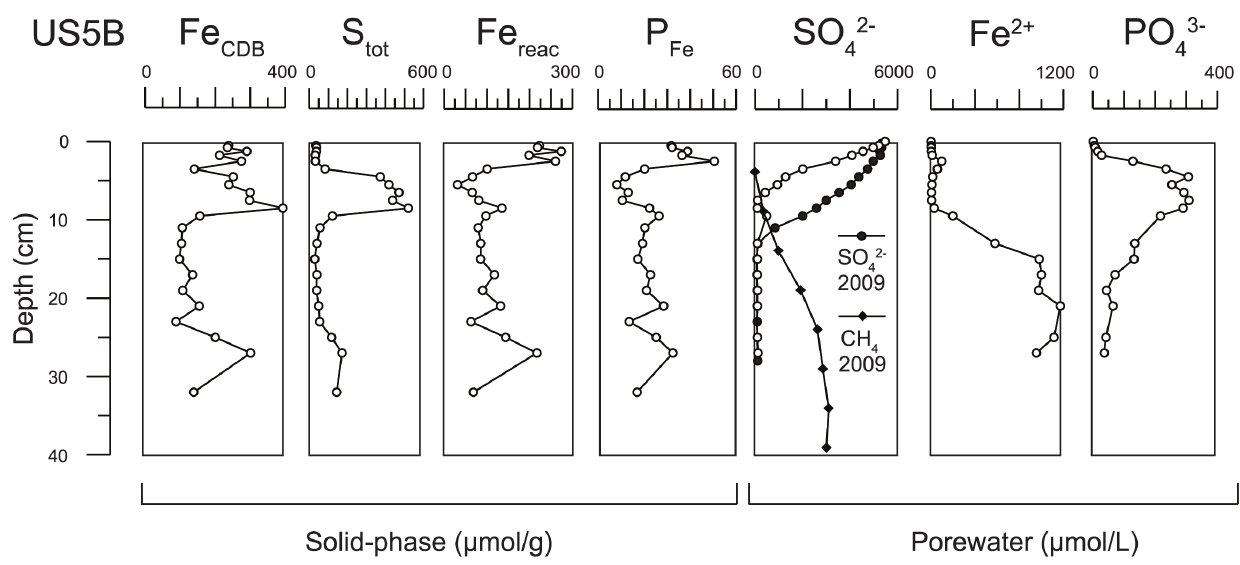
Figure 7. Compilation of key sediment and porewater profiles for US5B. Depth profiles of sediment contents of CDB-Fe, total sulfur (S tot ), reactive Fe oxides (Fe reac ; see text) and Fe-bound P in units of m mol/g, and depth profiles of porewater concentrations of methane, sulfate and dissolved Fe 2 + and PO 4 (in m mol/l) for site US5B. Data are for October 2008, unless indicated otherwise.